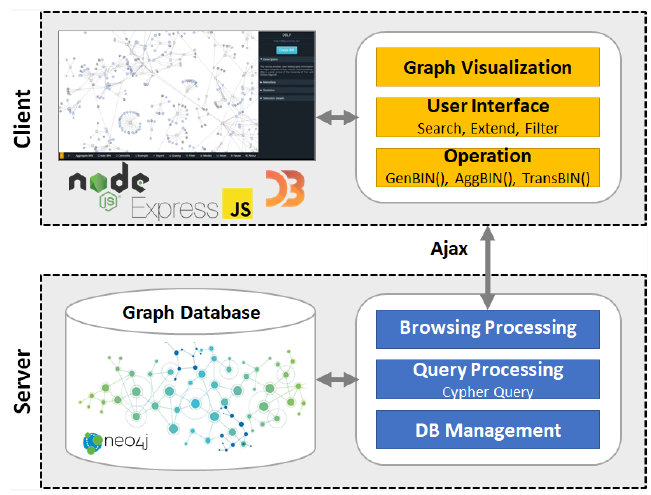
Figure 7. An Overall Architecture of OLGAVIS BIN Visualization System.